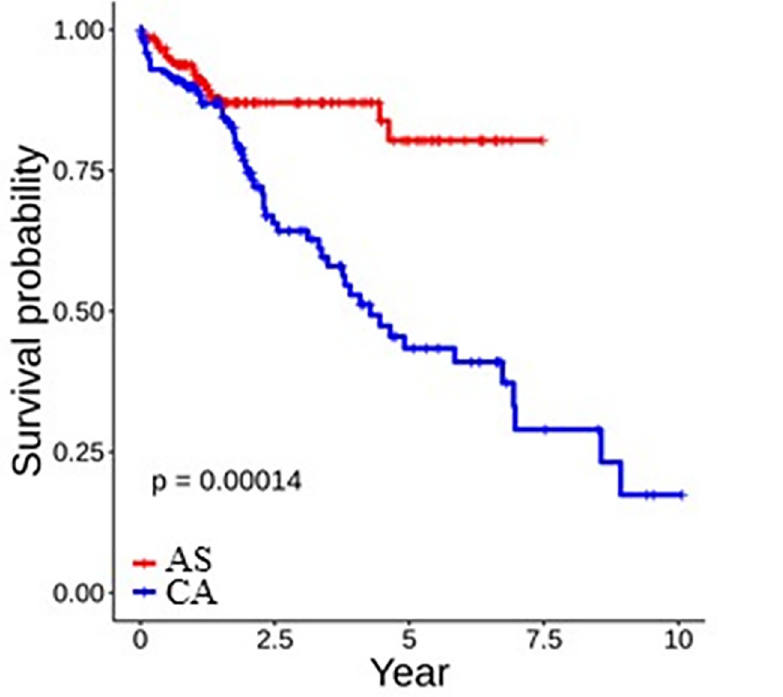
Fig 7. Survival curve of AS and CA groups. AS have higher survival rate that